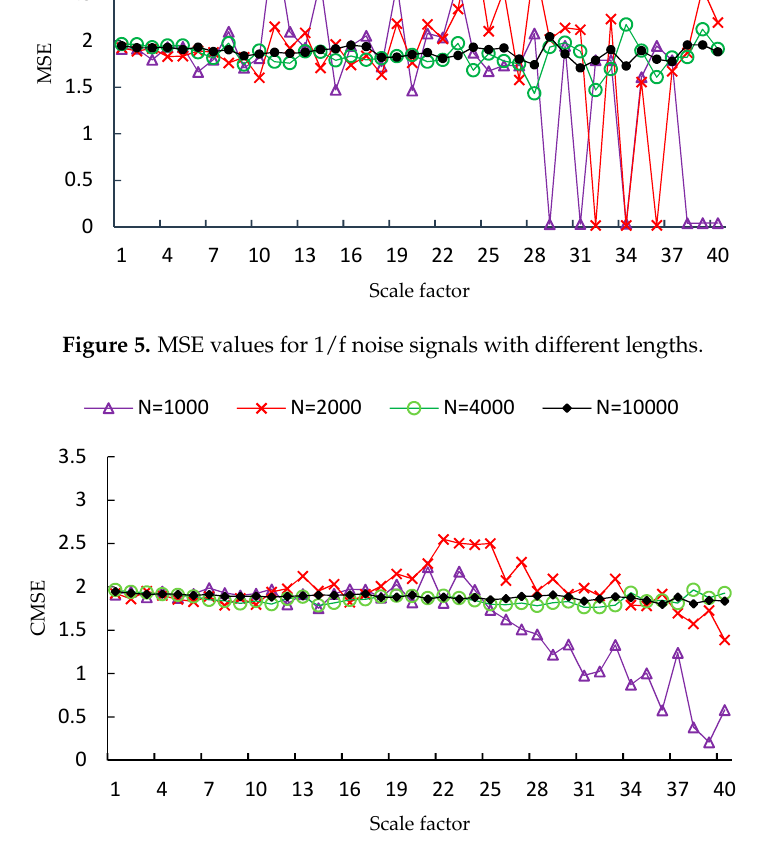
Figure 6. CMSE values for 1/f noise signals with different lengths.